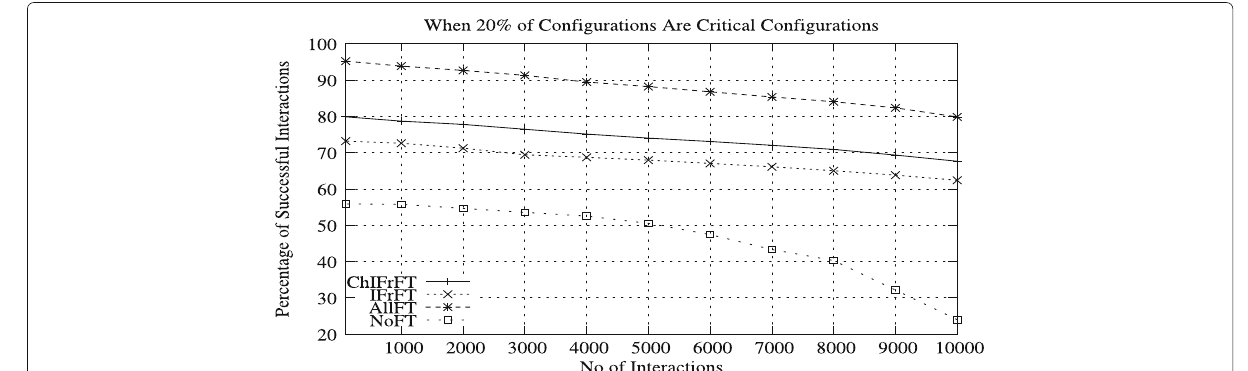
Fig. 17 Critical configurations are 20% of all configurations